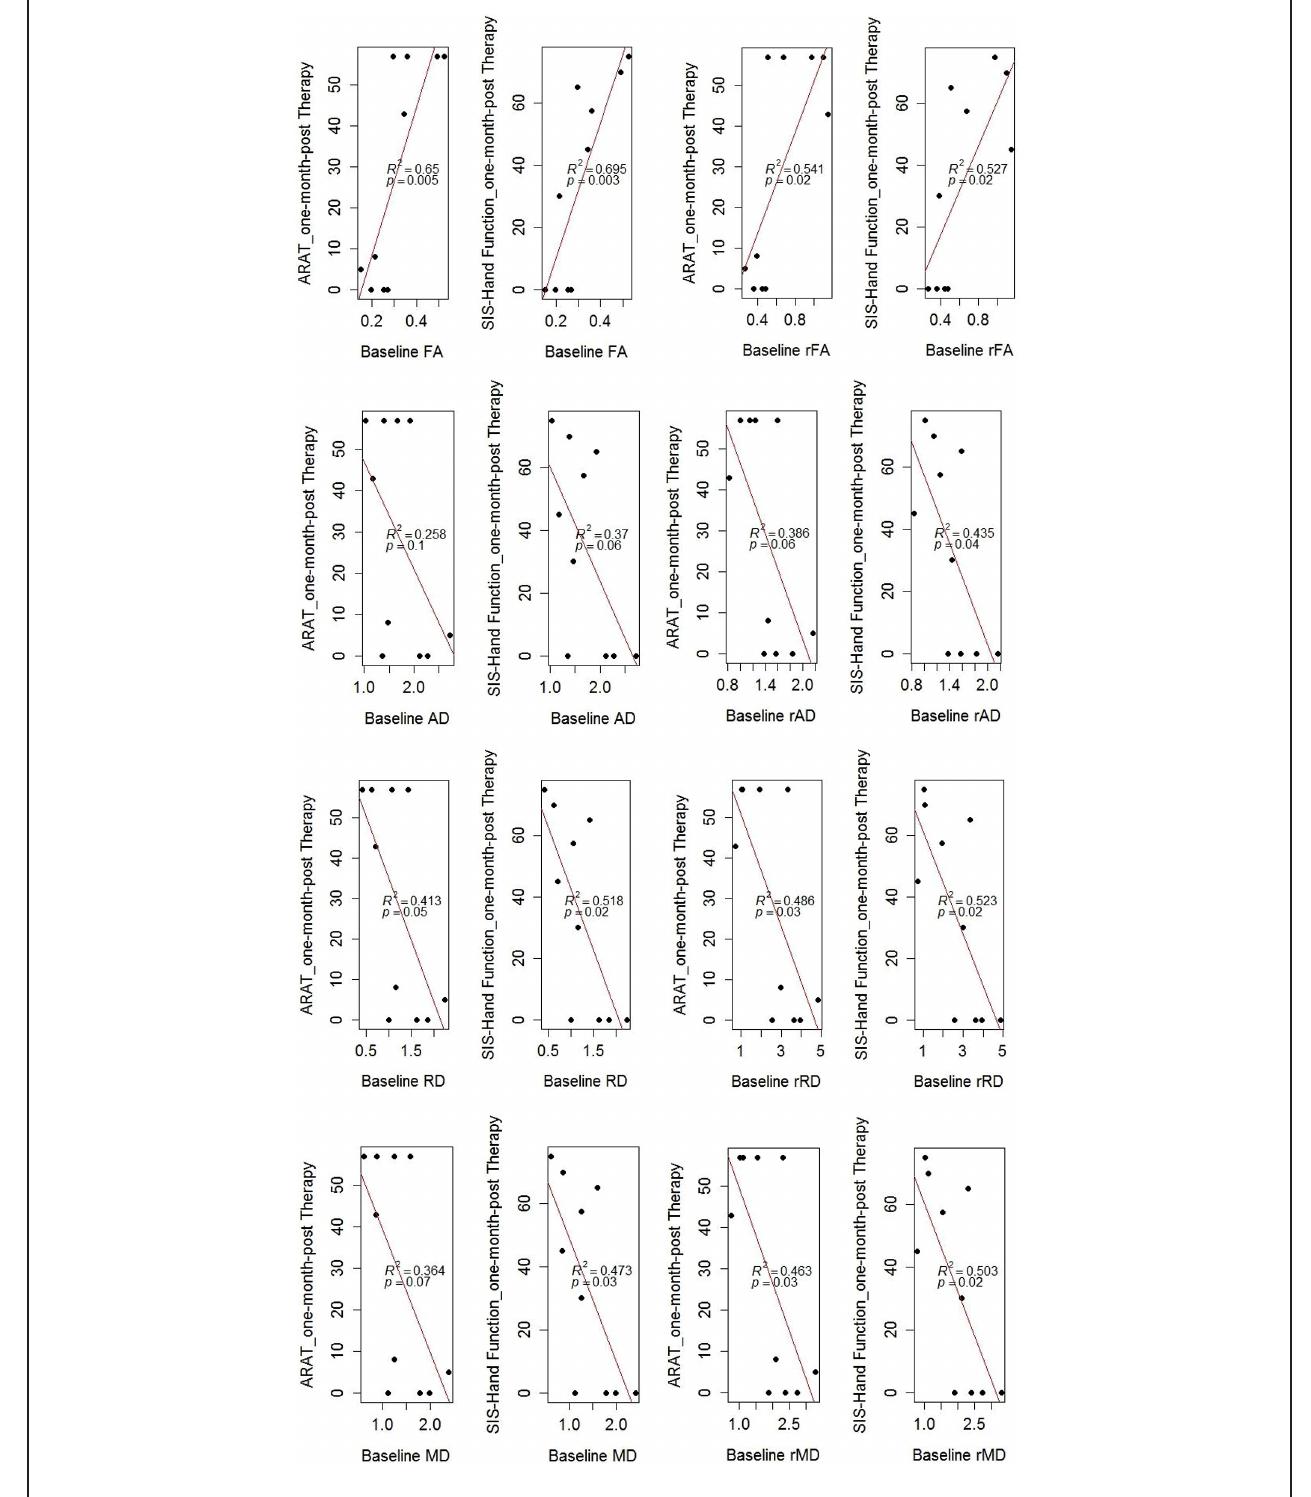
FIGURE 5 | Correlation of baseline DTI measures and motor outcomes evaluated 1-month-post intervention. Baseline DTI measures (i.e., evaluated at immediately pre-intervention) correlated with motor outcomes measured 1-month-post intervention. R -squared values